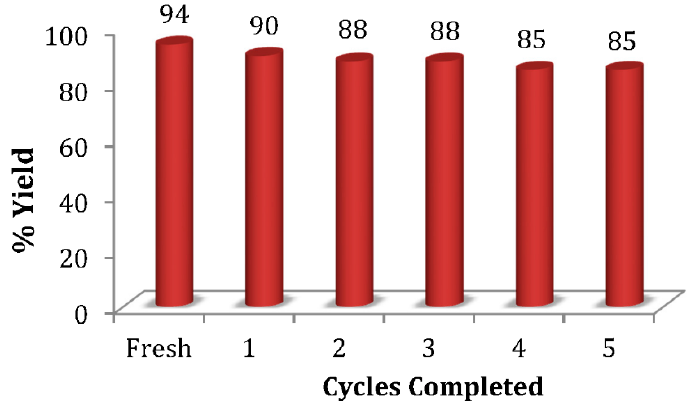
Figure 1. Recyclability of OSU-6.